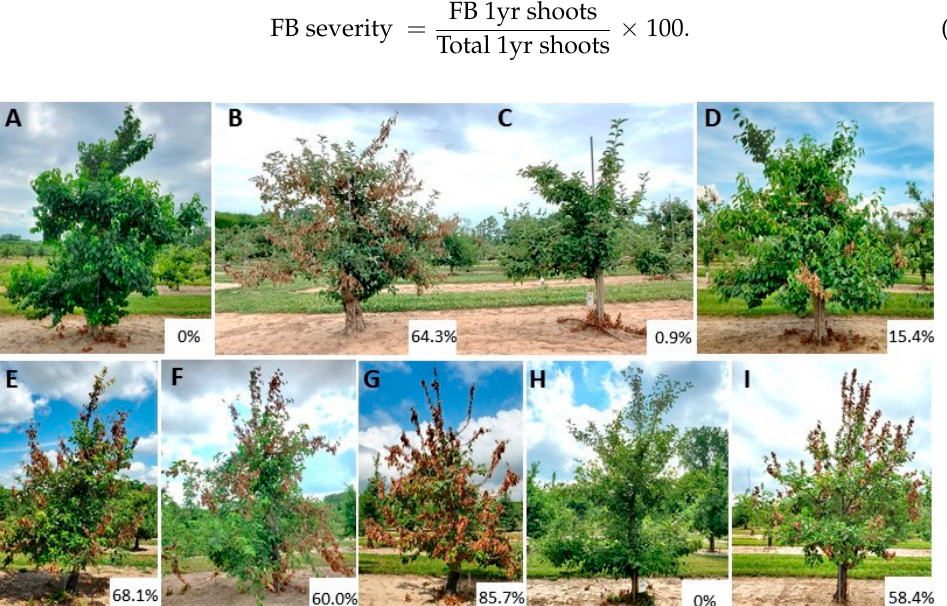
Figure 1. Examples of fire blight severity in the main collection. ( A ) Robusta 5 ( M. robusta ) ( B ) ‘Ribston’ ( M. domestica ) ( C ) ‘Honora’ ( M. domestica ) ( D ) ‘Sugar crab’ ( Malus hybrid ) ( E ) ‘Royal Gala’ ( M. domestica ) ( F ) KAZ 96 08-17 ( M. sieversii ) ( G ) ‘Skryzhapel’ ( M. domestica ) ( H ) GMAL 3173 ( M. baccata ) ( I ) ‘John Standish’ ( M. domestica ). The fire blight severity percentages are shown in bottom right of each panel. Pictures were taken during the initial fire blight scoring in late June 2020.